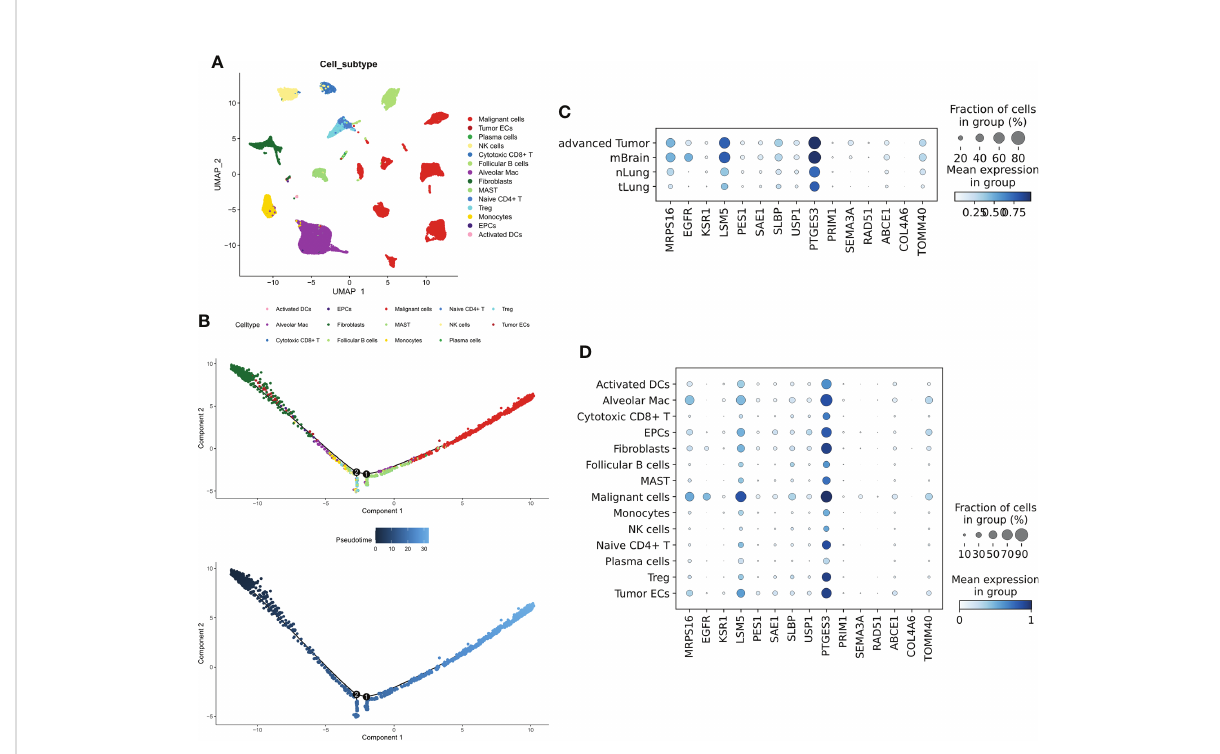
FIGURE 2 Single-cell transcriptional map of CRGs. (A) Umap plots of 14 cell subtypes. (B) Quasi sequential trajectories of 14 cell subtypes, top cell trajectories; bottom: Pseudotime trajectories. (C) Expression pro fi les of 15 prognostic CRGs in different tissues. (D) Expression pro fi les of 15 prognostic CRGs in different cell